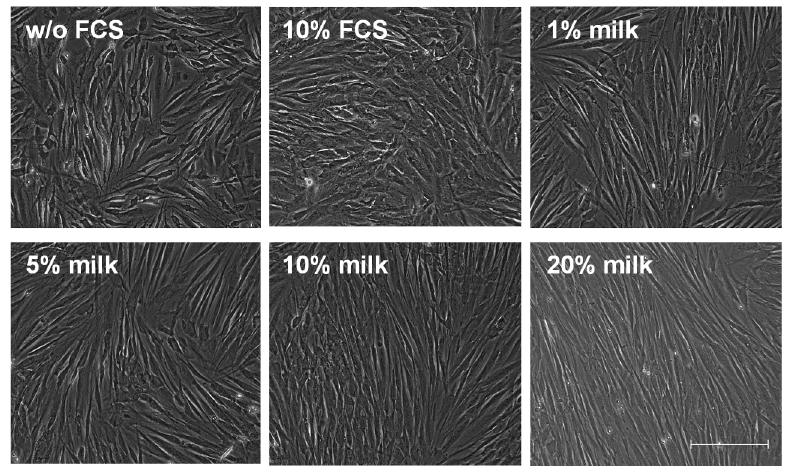
Fig 2. Bovine milk changes cell morphology. Normal human skin fibroblasts were cultured in regular medium without FCS or in the presence of 10% FCS, 1%, 5%, 10% and 20% bovine milk for 24 hours. Representative photographs are shown. Bar = 200 μ